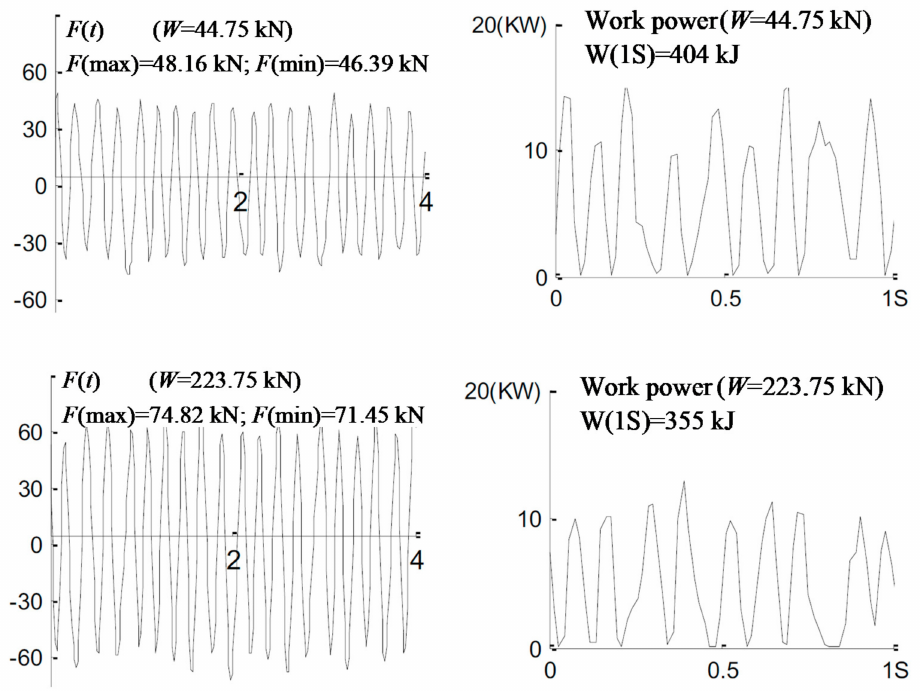
Figure 21. The time − domain diagrams of equivalent excitation force and its work power to the spring component under different bit